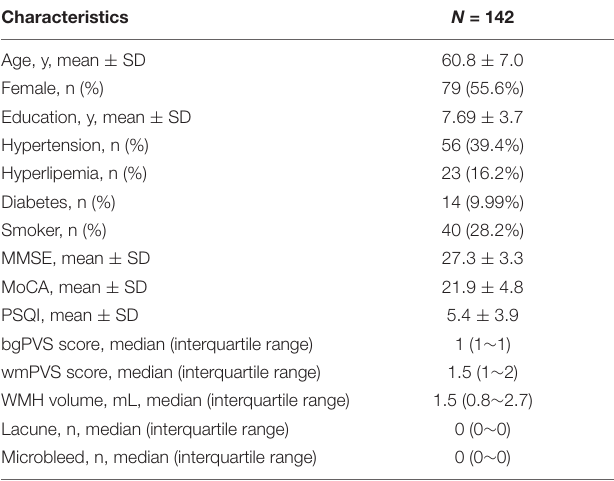
TABLE 1 | Characteristics of the